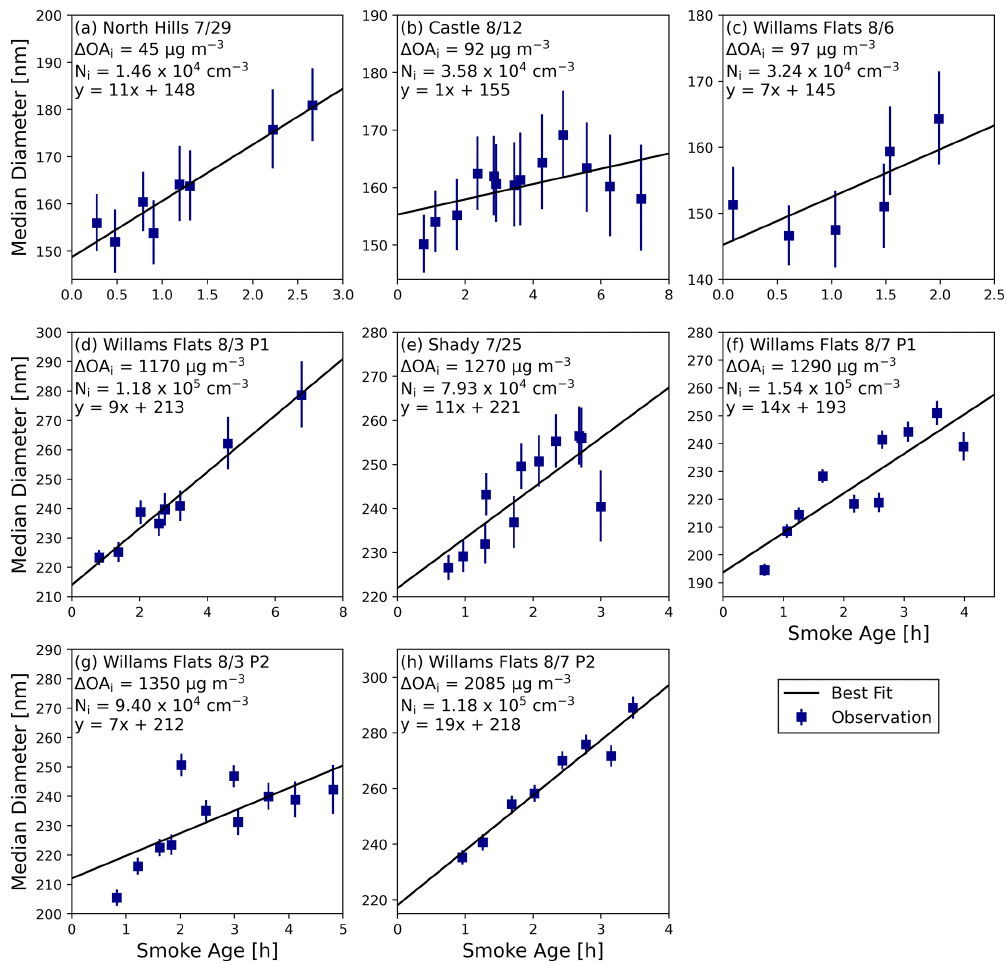
Figure 2. The median diameter ( D pm ) versus smoke age for each of the eight flights, organized so that (a) – (h) are in order of increasing (cid:49) OA i . The error bars represent the standard deviation of D pm within the transect.